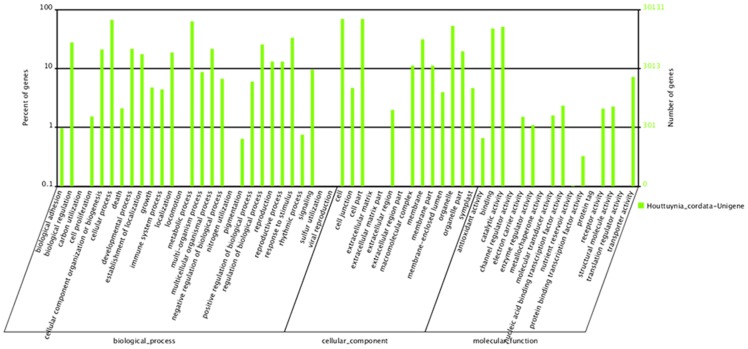
Gene ontology classification of assembled unigenes.